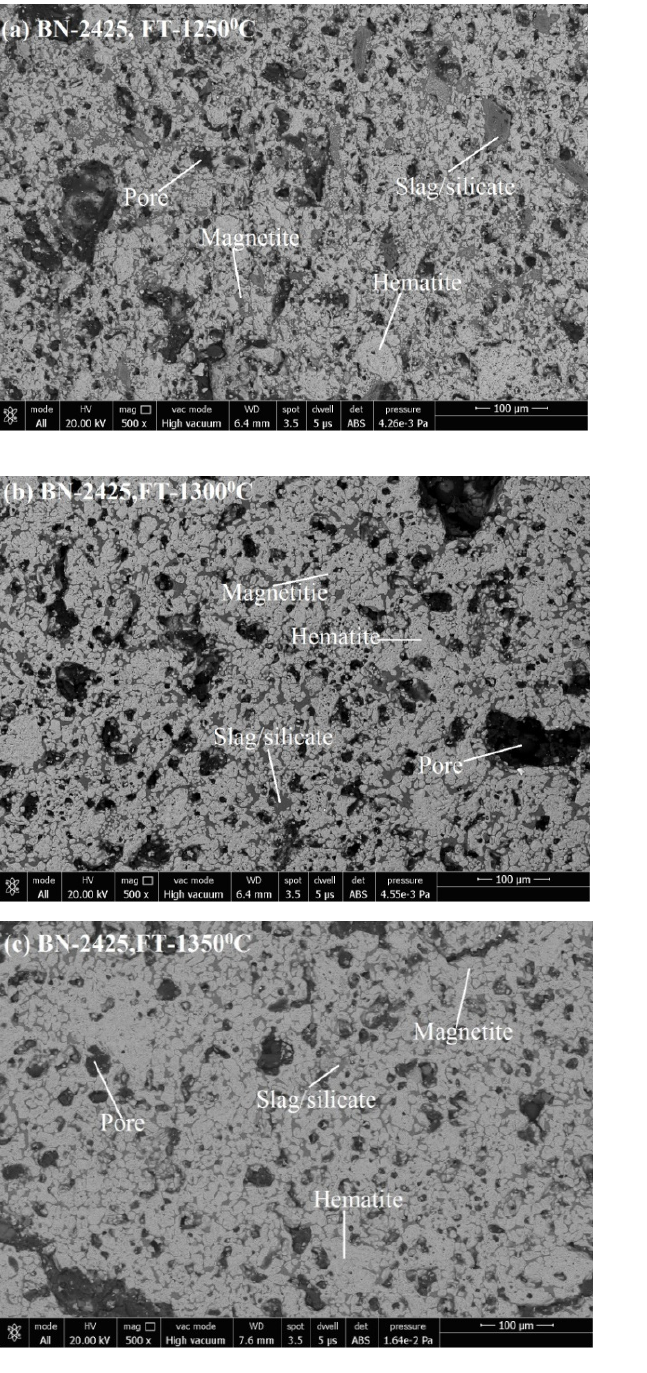
Figure 6. SEM Microstructure of ( a ) K3A, ( b ) K3B, ( c ) K3C, ( d ) K4A, ( e ) K4B, and ( f ) K4C pellets.